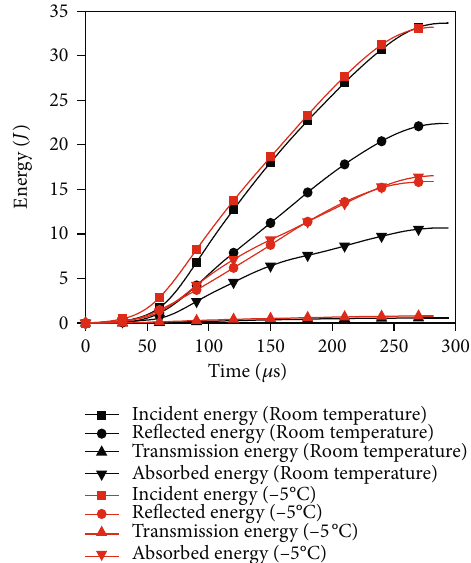
Figure 6: Energy distribution of saturated concrete.